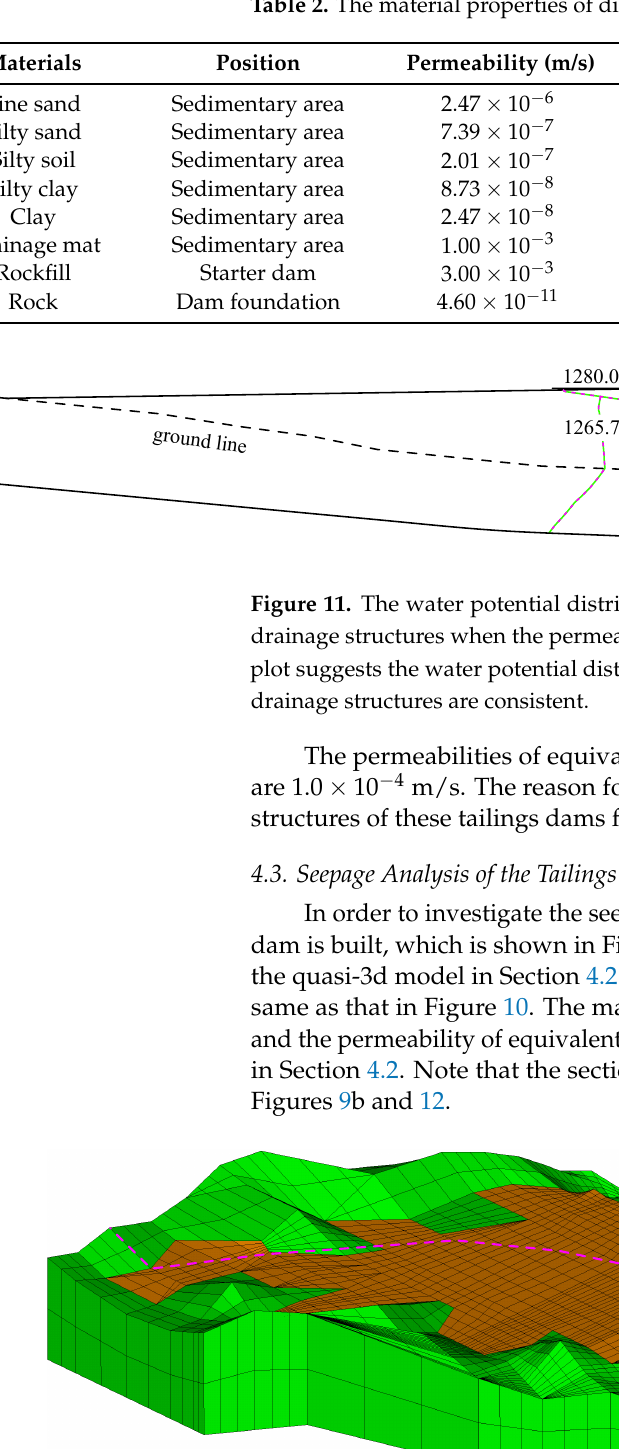
Table 2. The material properties of different zones in the tailings dam for case study.